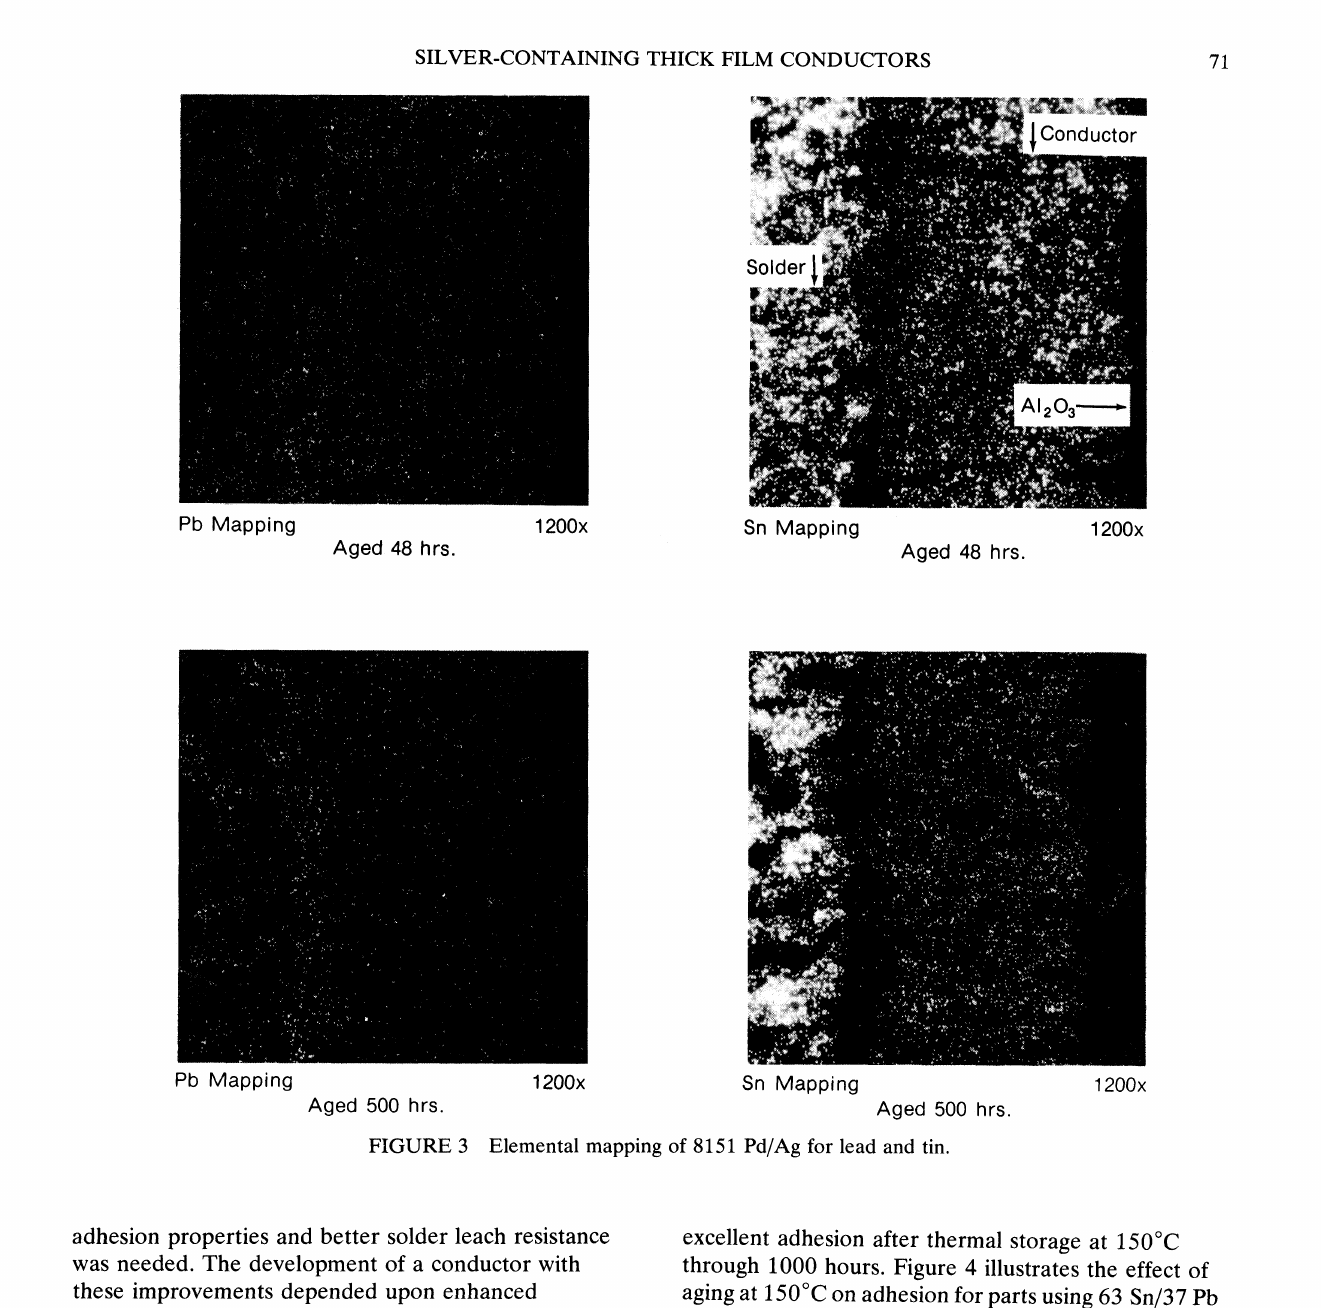
FIGURE 3 Elemental mapping of 8151 Pd/Ag for lead and